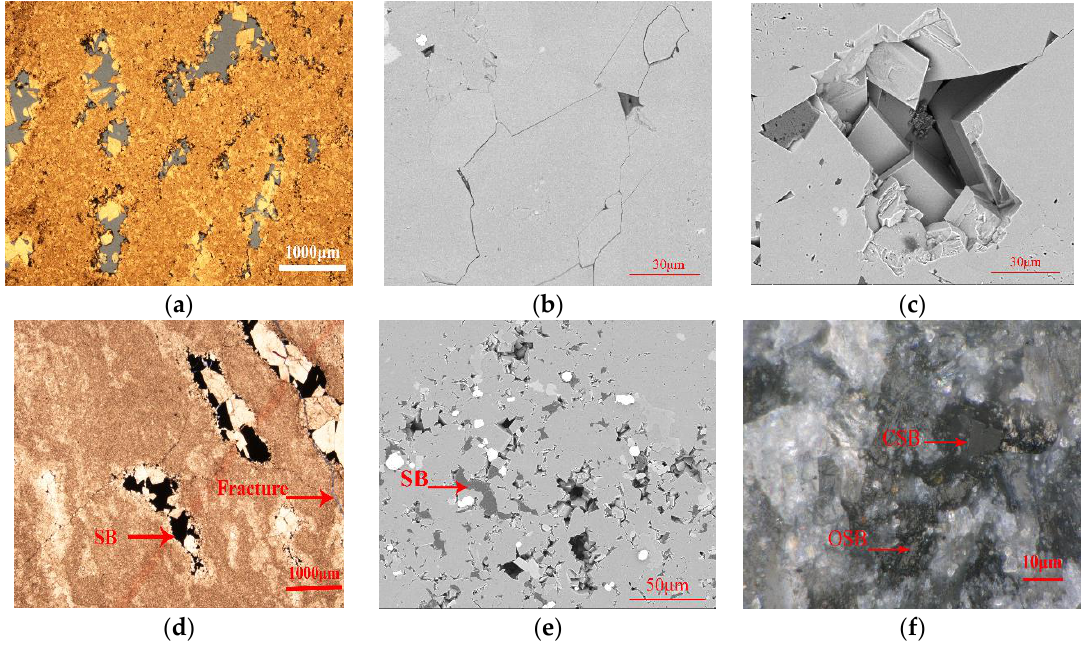
Figure 7. Pore structure characteristics of carbonate gas reservoirs: ( a ) Moxi-23 well, 4805.71 m, cavity development; ( b ) Gaoshi-7 well, 4834.90 m, fractures; ( c ) Gaoshi-7 well, 4834.90 m, pore; ( d ) Moxi-23 well, 4802.60 m, SB-filled cavities; ( e ) Gaoshi-7 well, 4834.90 m, SB-filled pores; ( f ) Moxi-41 well, 4805.67 m, carbon–SB and oil–SB.